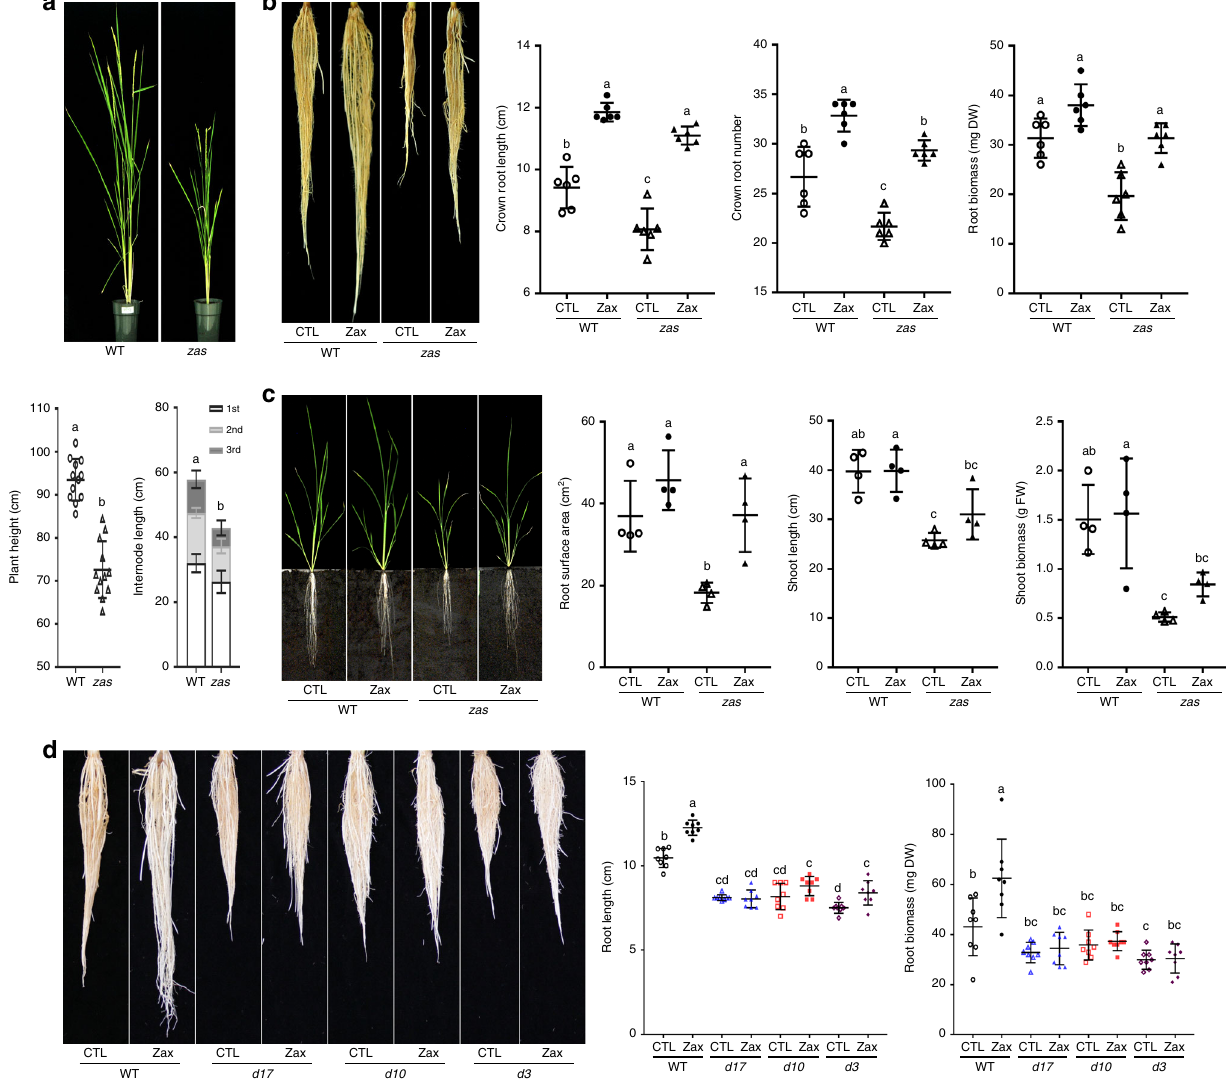
Fig. 2 Phenotypic characterization and rescue of zas mutant. a Nipponbare wild-type and zas mutant plants at heading stage. b Roots of hydroponically grown wild-type and zas mutant seedlings in the absence (Control) and presence of zaxinone (2.5 µ M). c Effect of zaxinone (10 µ M) on soil-grown (rhizotron) wild-type and zas mutant plants. d Effect of zaxinone (2.5 µ M) on root phenotype of Shiokari wild-type and ccd mutant seedlings grown hydroponically. Each data point represents one plant (a plant height n = 12, internode length n = 6; b n = 6; c n = 4; d n = 8). Data represent mean ± SD. Statistical analysis was performed using one-way analysis of variance (ANOVA) and Tukey ’ s post hoc test. Different letters denote signi fi cant differences ( P < 0.05). CTL Control, Zax the transcript levels of the SL biosynthesis enzymes DWARF27 (D27), CCD7 (D17), CCD8 (D10), and the 4-deoxyorobanchol- forming carlactone oxidase (CO) in wild-type and zas seedlings exposed to Pi-starvation and upon treatment with zaxinone (5 μ M). Under low Pi, the transcript levels of these genes were in